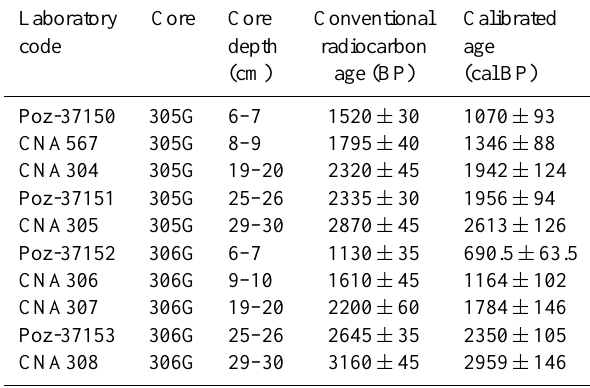
Table 1. Radiocarbon dates and calibrated ages for cores 305G and 306G. Results are reported with a 2 σ